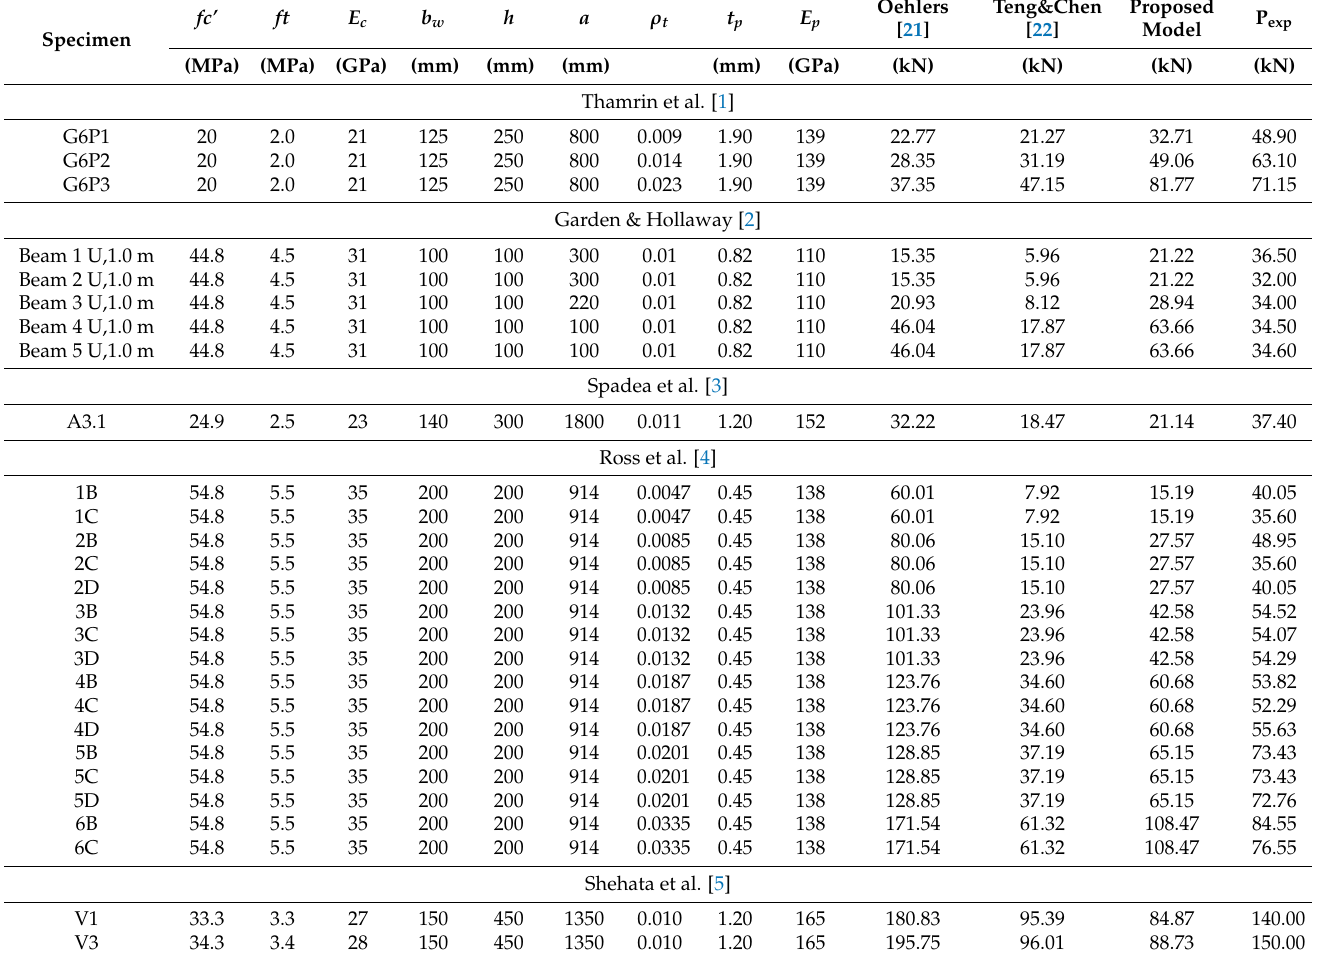
Table 2. Test results and theoretical values of the debonding